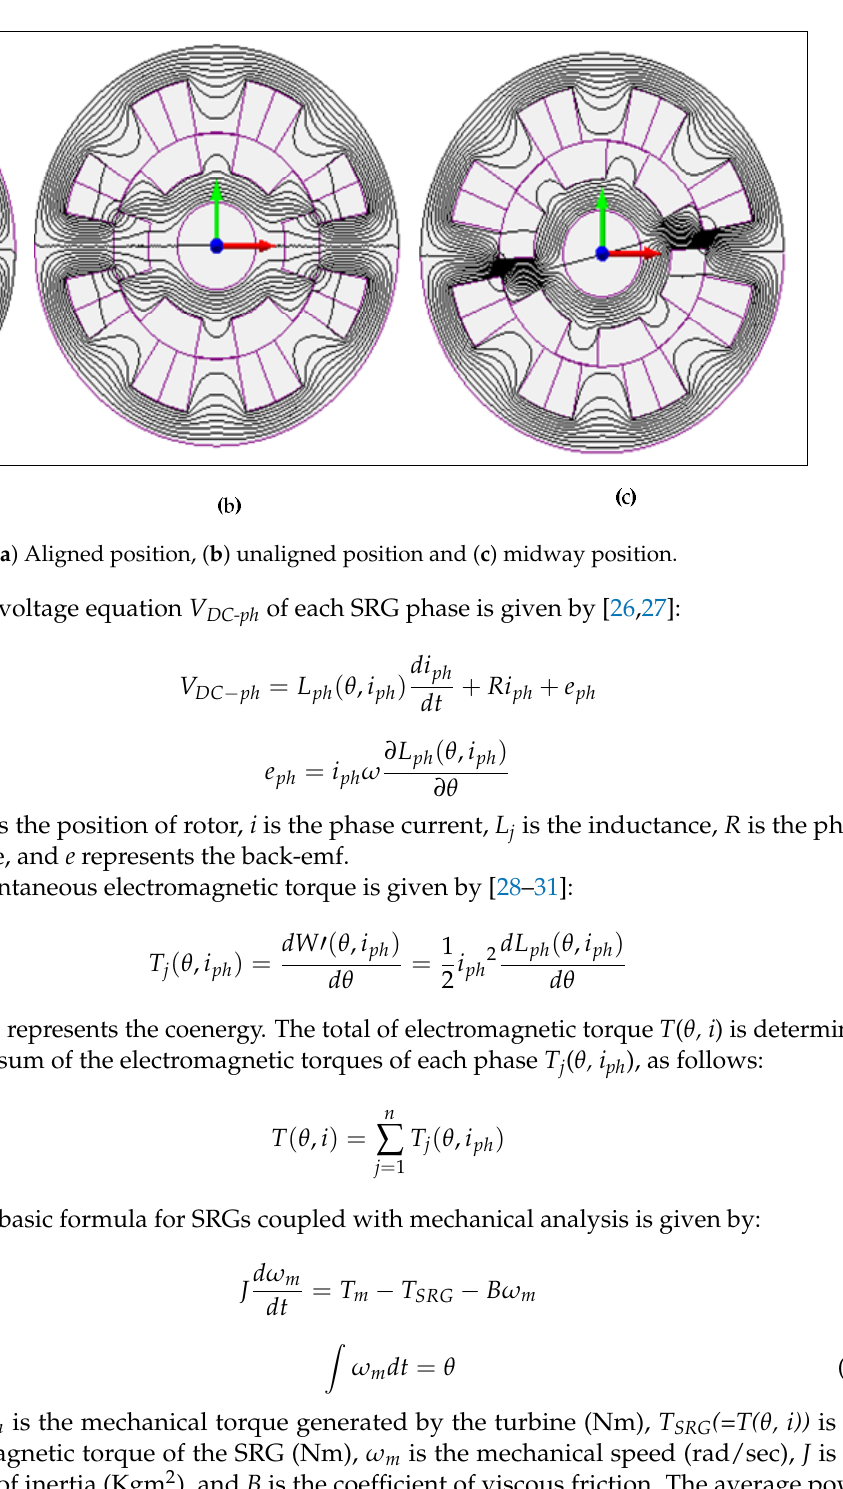
Figure 5. Inductance, voltage, and torque profile of one of the SRG phases.